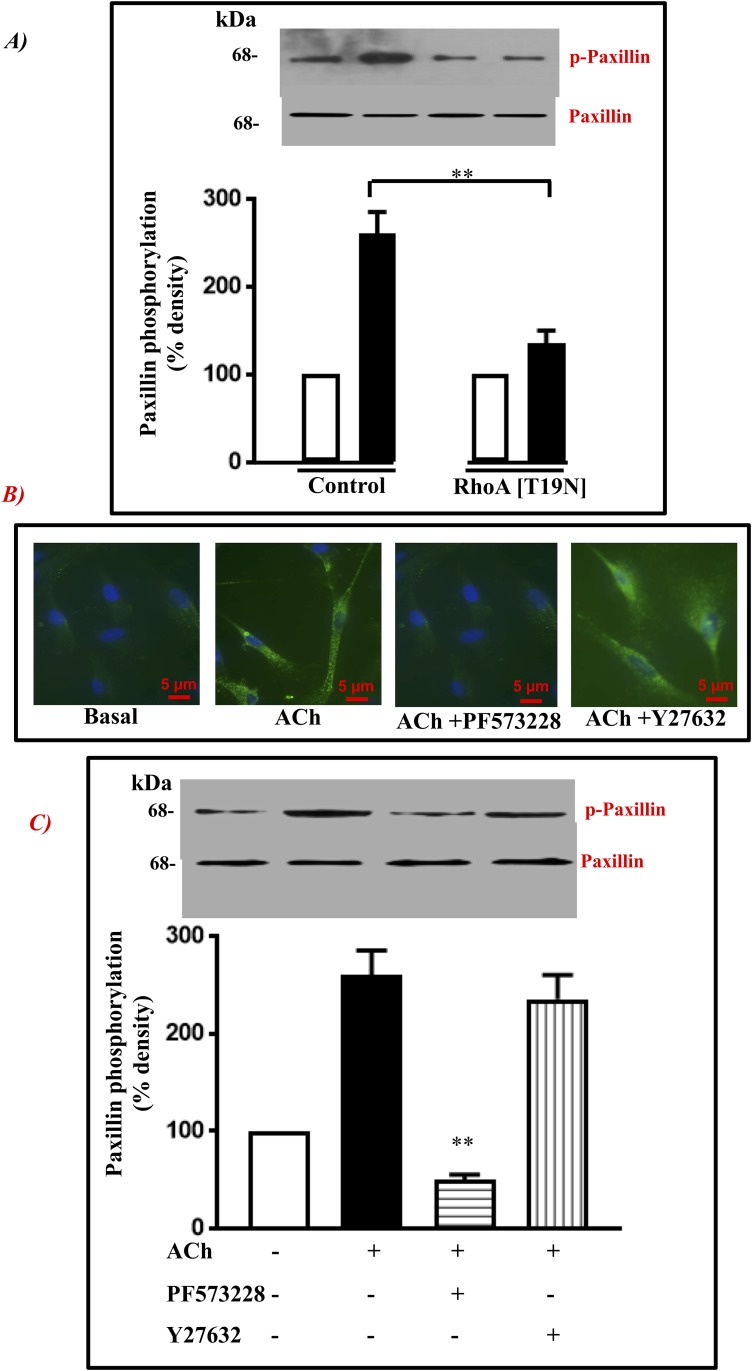
Stimulation of paxillin phosphorylation by ACh.A: Cultured smooth muscle cells expressing either control vector or RhoA dominant negative (RhoA [T19N]) were treated for 10 min with 1 μM ACh. Phosphorylation of paxillin was measured using phospho specific Tyr paxillin antibody (Y118) and results are expressed as densitometric values. Values are means ± SE for three experiments. B: Immunostaining of paxillin phosphorylation in cultured smooth muscle cells were treated with 1 μM ACh for 10 min in the presence or absence of Rho kinase inhibitor Y27632 (10 μM, 10 min), FAK inhibitor PF 573228 (10 μM, 10 min). C: Immunoblots of paxillin and phospho paxillin from extracts of smooth muscle cells either unstimulated or stimulated with 1 μM ACh in the presence or absence of Rho kinase inhibitor Y27632 (10 μM, 10 min), or FAK inhibitor PF 573228 (10 μM, 10 min). Phosphorylation of paxillin was measured using phospho-specific Tyr118 paxillin antibody. The results are expressed as densitometric values. Values are means ± SE of four experiments. **P<0.001.